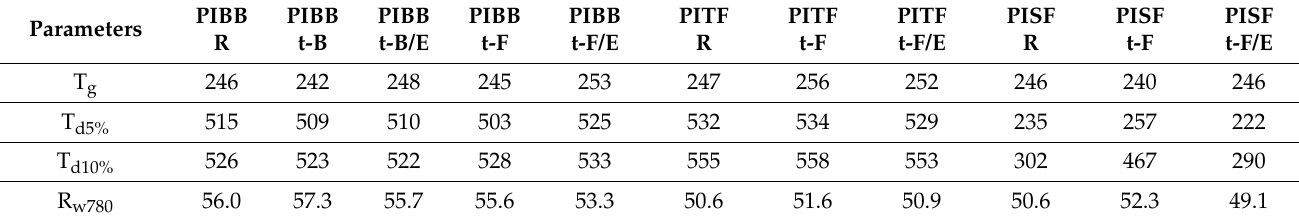
Figure 7. T g , T d5% , T d10%, and R w780 comparison of the PI films capped with different blockers: ( A ) PIBB R /PIBB t-B /PIBB t-B/E ; ( B ) PIBB R /PIBB t-F /PIBB t-F/E ; ( C ) PITF R /PITF t-F /PITF t-F/E ; and ( D ) PISF R /PISF t-F /PISF t-F/E . Table 4. Thermal properties of PIBBs, PITFs, and PISFs.